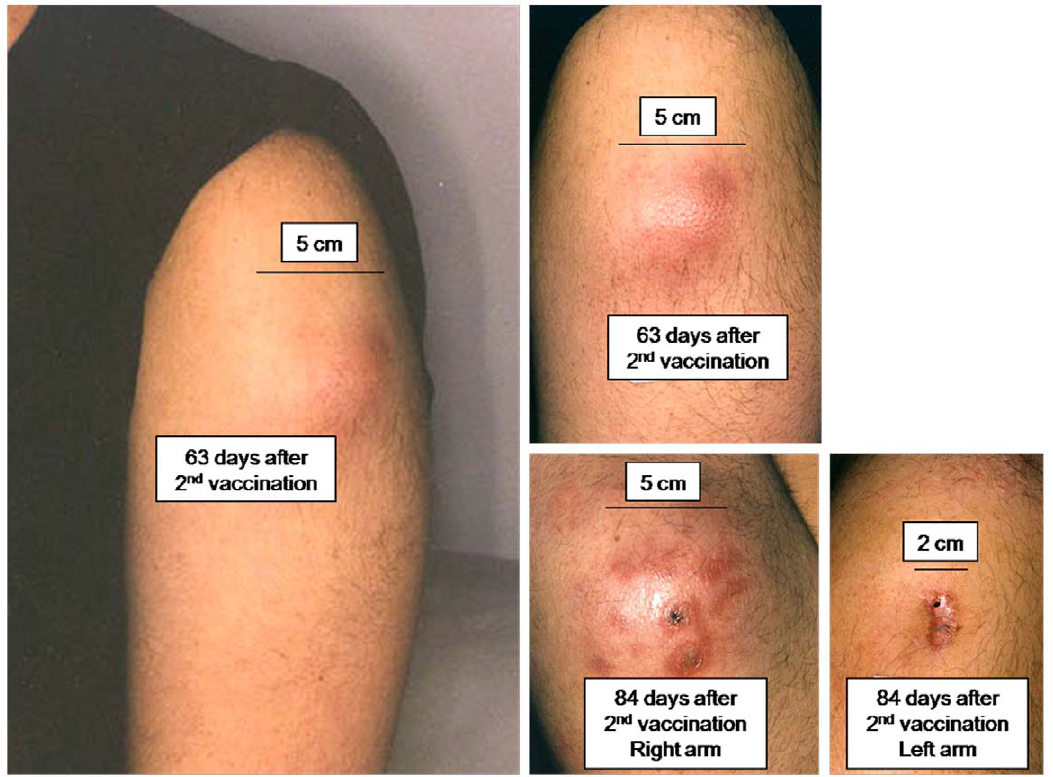
Figure 1. Case report of local reaction and sterile abscess formation. Two days after the 1 st immunization, a 22 year old man in the 1 mg dose cohort developed mild tenderness over the injection site that resolved on day 4. After the 2 nd immunization was administered 28 days later, mild tenderness occurred that lasted for one day. 15 days after the 2 nd immunization a 0.25 cm asymptomatic subcutaneous nodule was detected on routine physical exam. There was no erythema at that time. Fifty days post 2 nd immunization the volunteer reported the onset of throbbing pain and that was treated with warm compresses and nonsteroidal anti-inflammatory drugs. On day 56 there was erythema and induration of 8 and 9 cm diameter over the prior injection sites, and the subject was afebrile with a WBC of 9,600/cm 2 . On day 63 there was less pain and the area of induration was unchanged. However, the induration was less firm and the central area of erythema (A and B) was fluctuant. On day 84 there was spontaneous drainage from the lesions, from multiple fistulas on the right arm (C) and a single fistula on the left (D). The clinical course of all 4 subjects with sterile abscess formation is reviewed in Table S2.